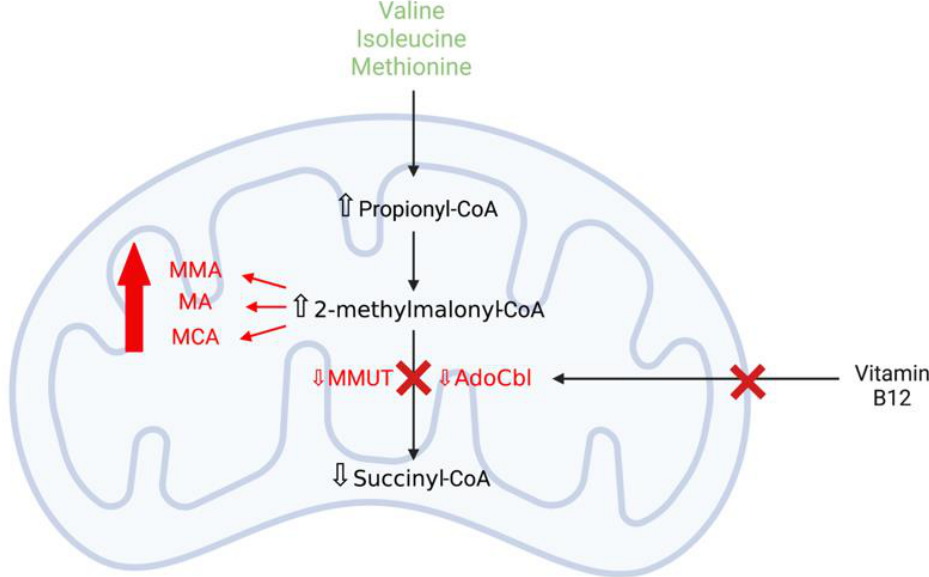
Figure 6. Defective metabolic pathway in methylmalonic acidaemia. A deficiency in the activity of MMUT or defects in the uptake, transport, and synthesis of the MMUT cofactor, AdoCbl, causes methylmalonic acidaemia. Vitamin B12 is an essential cofactor for MMUT. MMUT is essential for the degradation of the amino acids, valine, isoleucine, and methionine, and defects in this enzyme increase the concentration of MMA and its secondary metabolites, MA and MCA, in body fluids. These metabolites are mitochondrial toxins capable of inducing oxidative stress and excitotoxicity (created using biorender.com). MMA — methylmalonic acid; MA — malonic acid; MCA — 2-methylcitrate; MMUT — L -methylmalonyl-CoA mutase; AdoCbl —5′ -deoxyadenosylcobalamin; CoA — coenzyme A.